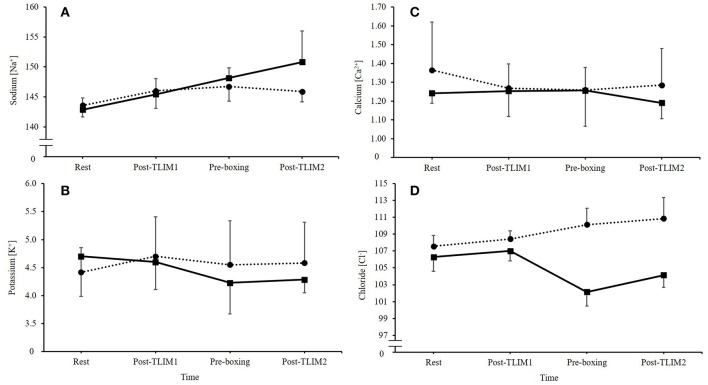
Changes in extracellular electrolytes following NaHCO3 or PLA, where (A) sodium [Na+], (B) potassium [K+], (C) calcium [Ca2+], and (D) chloride [Cl−].